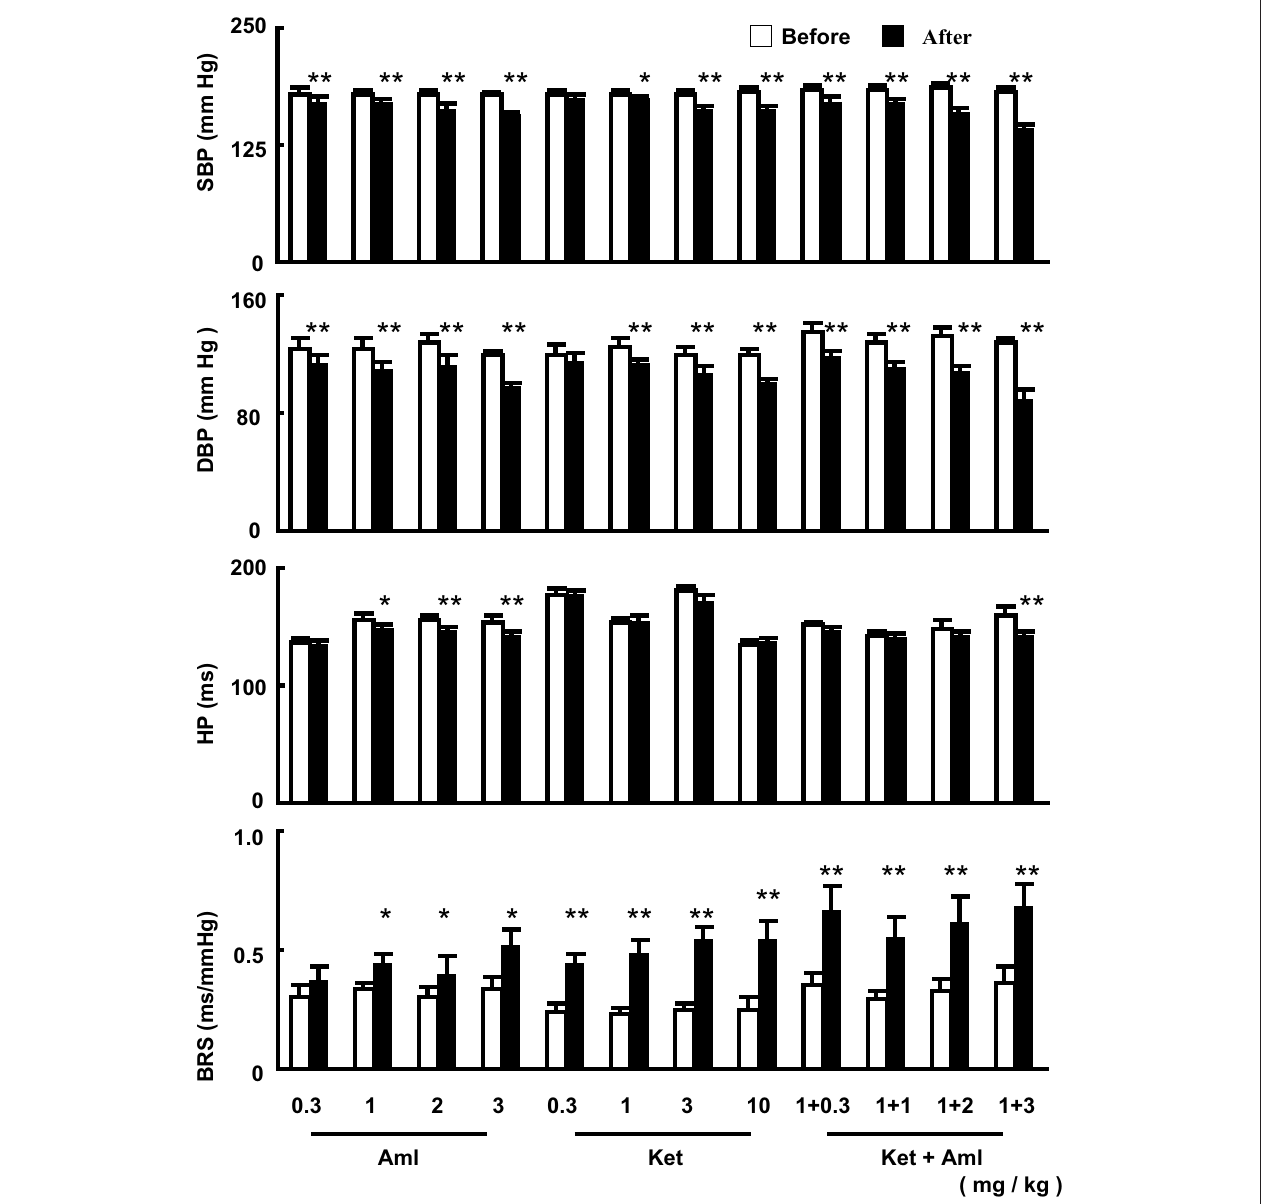
FiGure 1 | The effects of a single dose of amlodipine (Aml) and ketanserin (Ket) or combination on systolic blood pressure (SBP), diastolic blood pressure (DBP), heart period (HP) and baroreflex sensitivity (BrS) in conscious SHr-SP. The values are expressed as mean ± SE. * P < 0.05, ** P < 0.01 after drug vs. before drug. n = 9 in each